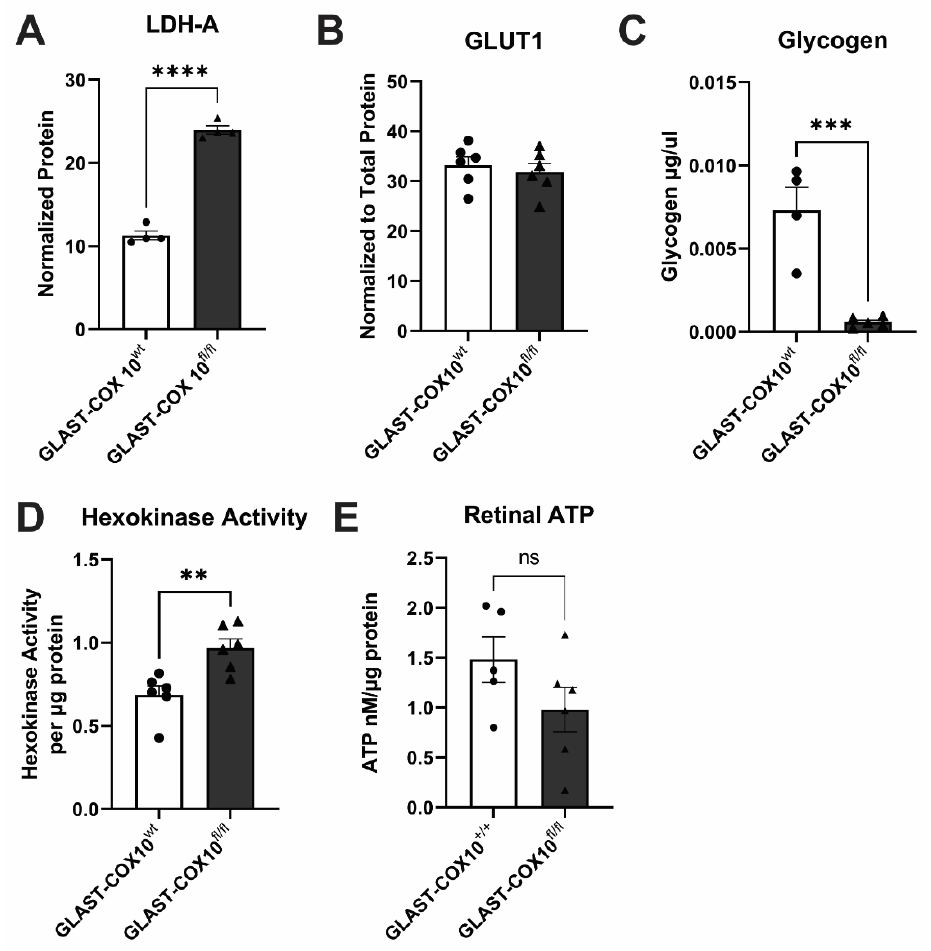
Figure 4. Bioenergetic changes in wildtype and GLAST-COX10 fl/fl mice. ( A ) Total LDH-A levels as measured by capillary electrophoresis are significantly increased in the GLAST-COX10 fl/fl retina as compared to wildtype control (two-tailed t -test, **** p < 0.0001). ( B ) Total GLUT1 protein levels are unchanged after destabilization of COXIV in MG as compared to wildtype control. ( C ) Total retina glycogen levels are significantly decreased in GLAST-COX 10 fl/fl retina as compared to wildtype control (two-tailed t -test, *** p = 0.0090). ( D ) Hexokinase activity is significantly increased in whole retinal lysates from GLAST-COX10 fl/fl mice as compared to wildtype control (two-tailed t -test, ** p = 0.0047). ( E ) Whole retinal-lysate ATP levels were not different between wildtype control and GLAST-COX10 fl/fl retinas. n = 5 – 6, mean + SEM.